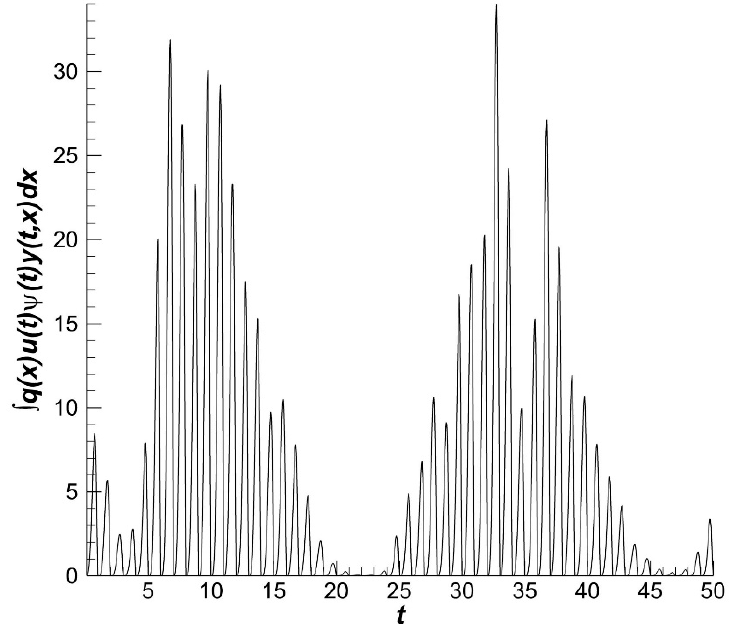
(cid:2868) (cid:82) 1 q ( x ) u ( t , x ) ψ ( t ) y ( t , x ) dx . 0 (cid:2868)